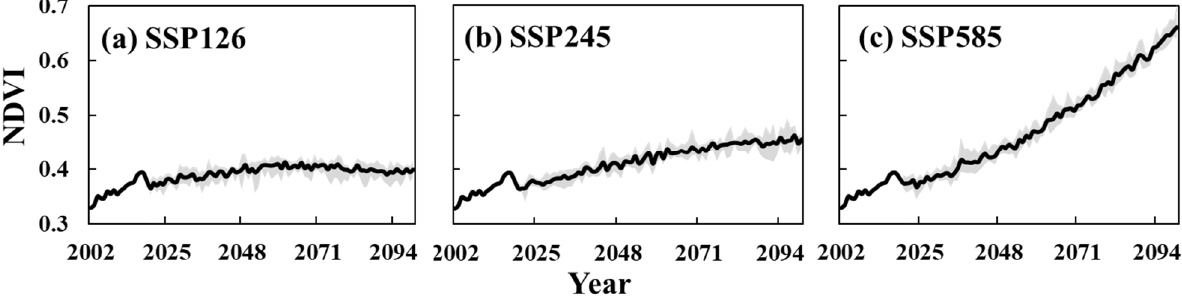
Figure 8. Future normalized difference vegetation index (NDVI) simulations from CMIP6 scenarios (SSP126, SSP245 and SSP585). Black solid line after 2020 indicates the mean value of NDVI in different models. The gray shaded area indicates the range of NDVI in the scenario.